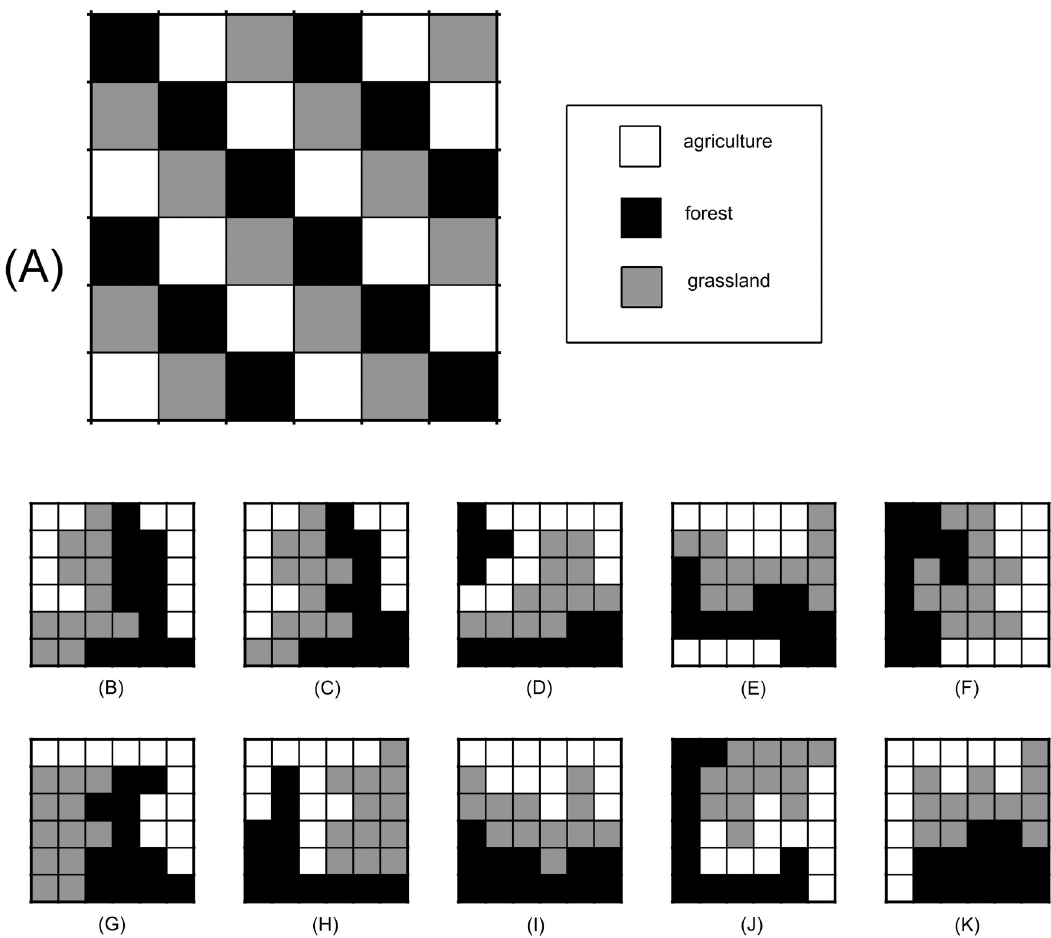
Fig 5. Multiple locally optimal landscapes. Example 2: dissimilar viable candidates . (A) Second hypothetical initial landscape. No dominant minimal paths exist for this initial landscape. These landscapes were derived from locally optimal paths that minimally deviated from the notion of a dominant minimal path (i.e., arose either from a minimal path that was not ideal, or a locally optimal path that required one more PE than an associated minimal path). (B)-(E) A selection of four of the 179 unique, locally optimal landscapes associated with the initial landscape in (A) and that are not global optima (all patches are not connected). (F)-(K) Six additional unique, locally optimal landscapes that also arose from (A). These landscapes are global optima as well (all patches are connected). Unlike (B)-(K) in Fig 4, (B)-(K) in this figure demonstrate that some initial landscapes lead to viable options that are very different from one another. The minimal deviants considered here were either derived from (i) minimal paths that were not increasing (Figs 4J and 5B), or (ii) locally optimal paths that required one additional PE, compared to that of a minimal path (Figs 4K and 5C–5K). Note that with some initial landscapes, all viable candidates are very similar (Fig 4B–4K), and with others, the viable candidates are quite different (Fig 5B–5K). Both the number of viable candidates and the differences among the candidates are dependent on how close the initial landscape is to a local optimum, and also the criteria used to define a minimal deviant.